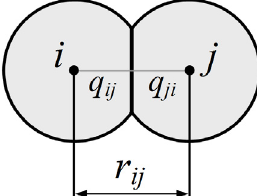
Figure 2: Parameters of spatial relation of the pair of discrete elements i and j : distance between mass centers ( r mass centers of interacting elements to the center of plane of interaction ( q